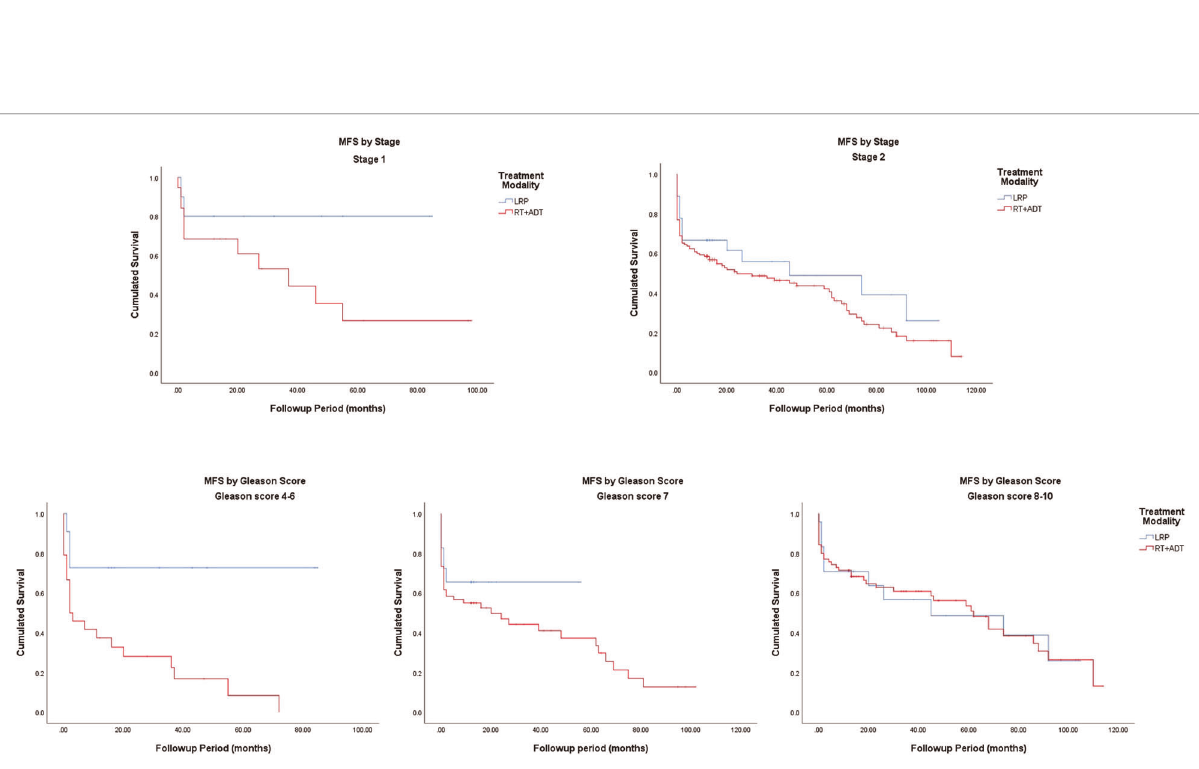
FIGURE 4 Metastasis-free survival by stage and Gleason